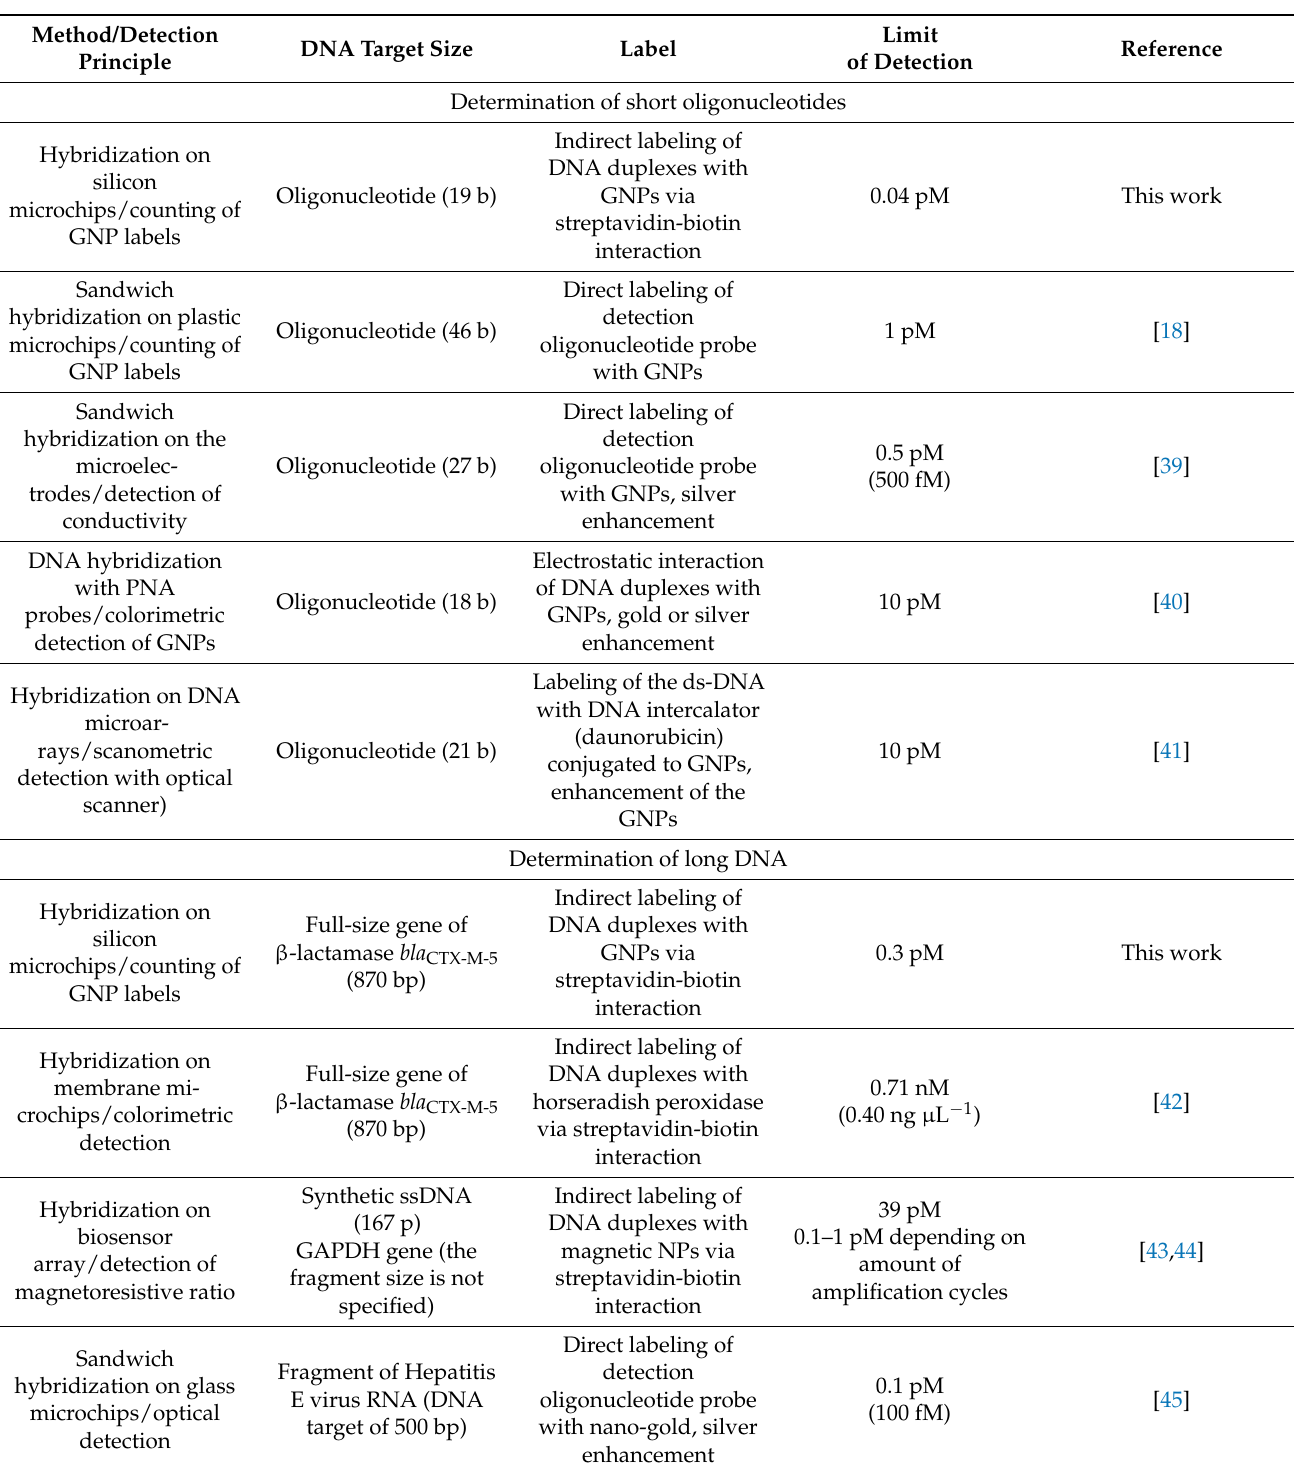
Table 3. Analytical performances of different methods developed for quantitative determination of